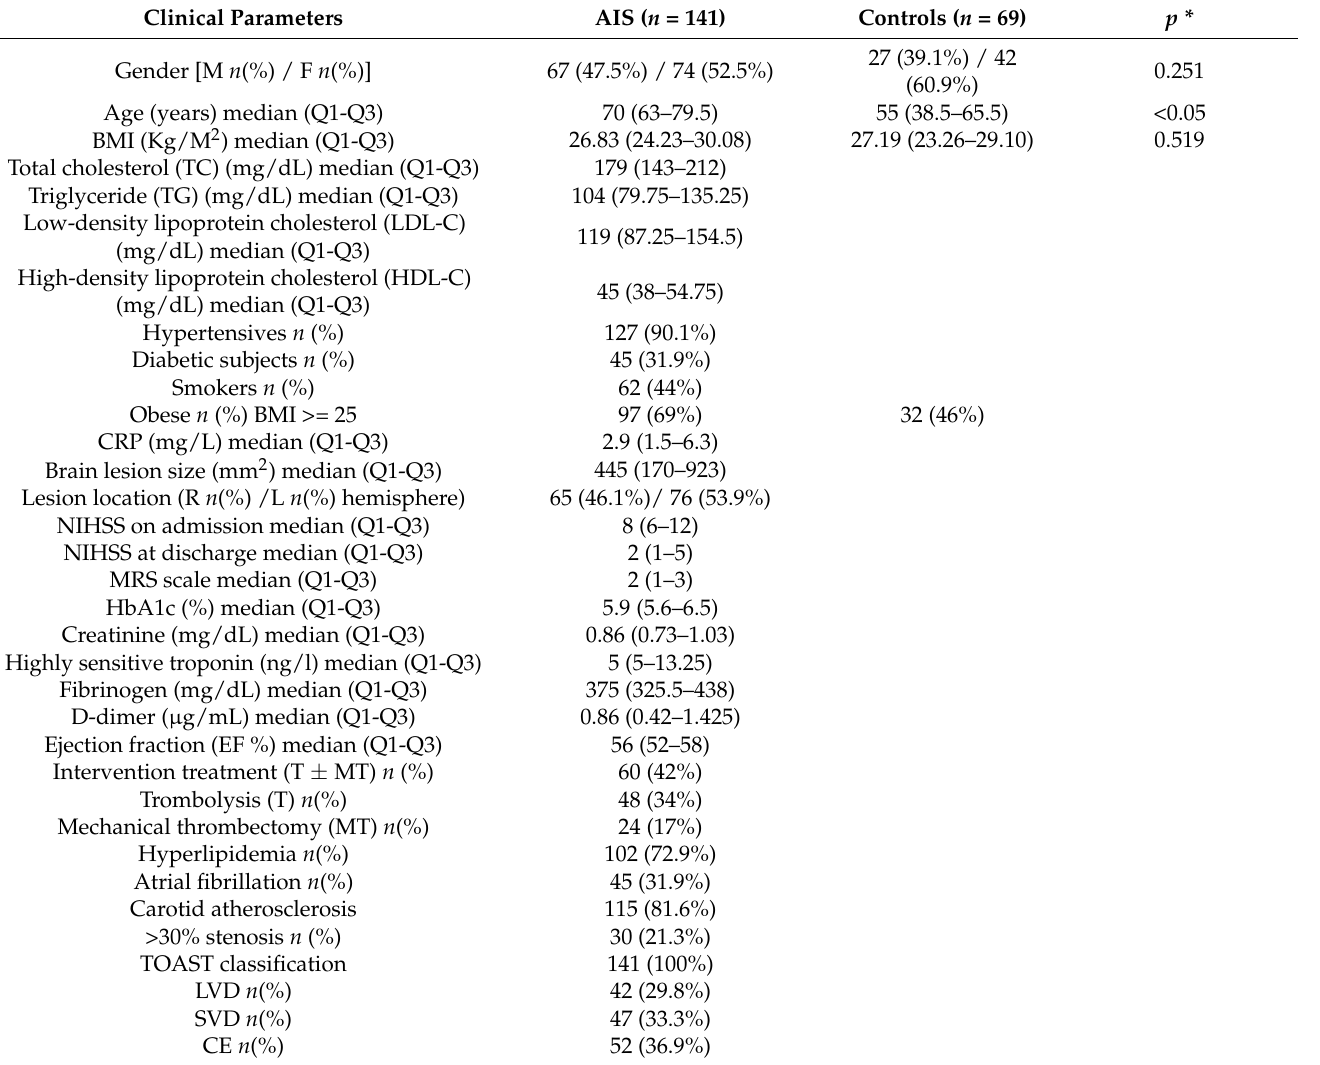
Table 1. Demographic data and biochemical values of study